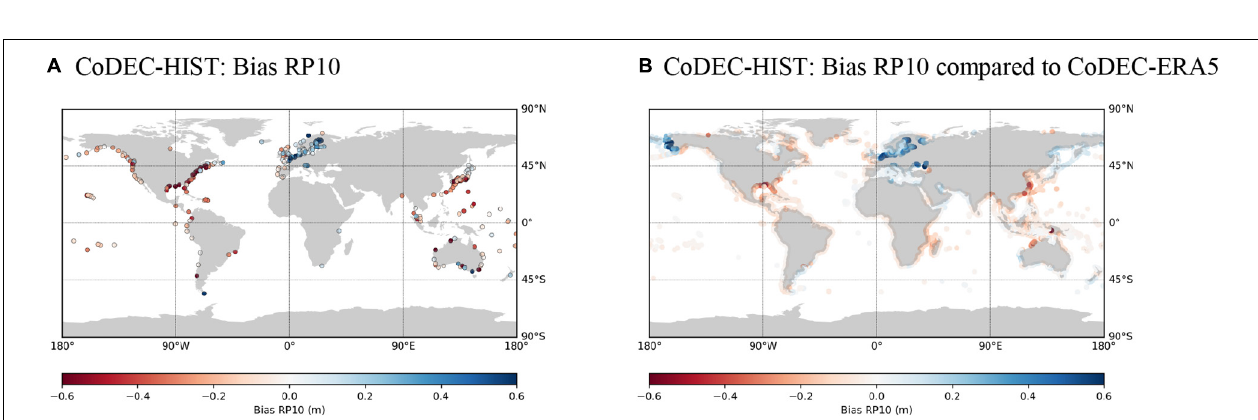
FIGURE 6 | Model performance of 1 in 10-year water levels for the CoDEC-HIST simulation shows as (A) the bias of the 1 in 10-year water levels compared against observations from the GESLA dataset and (B) the difference between the 1 in 10-year return periods derived from CoDEC-HIST and CoDEC-ERA5.